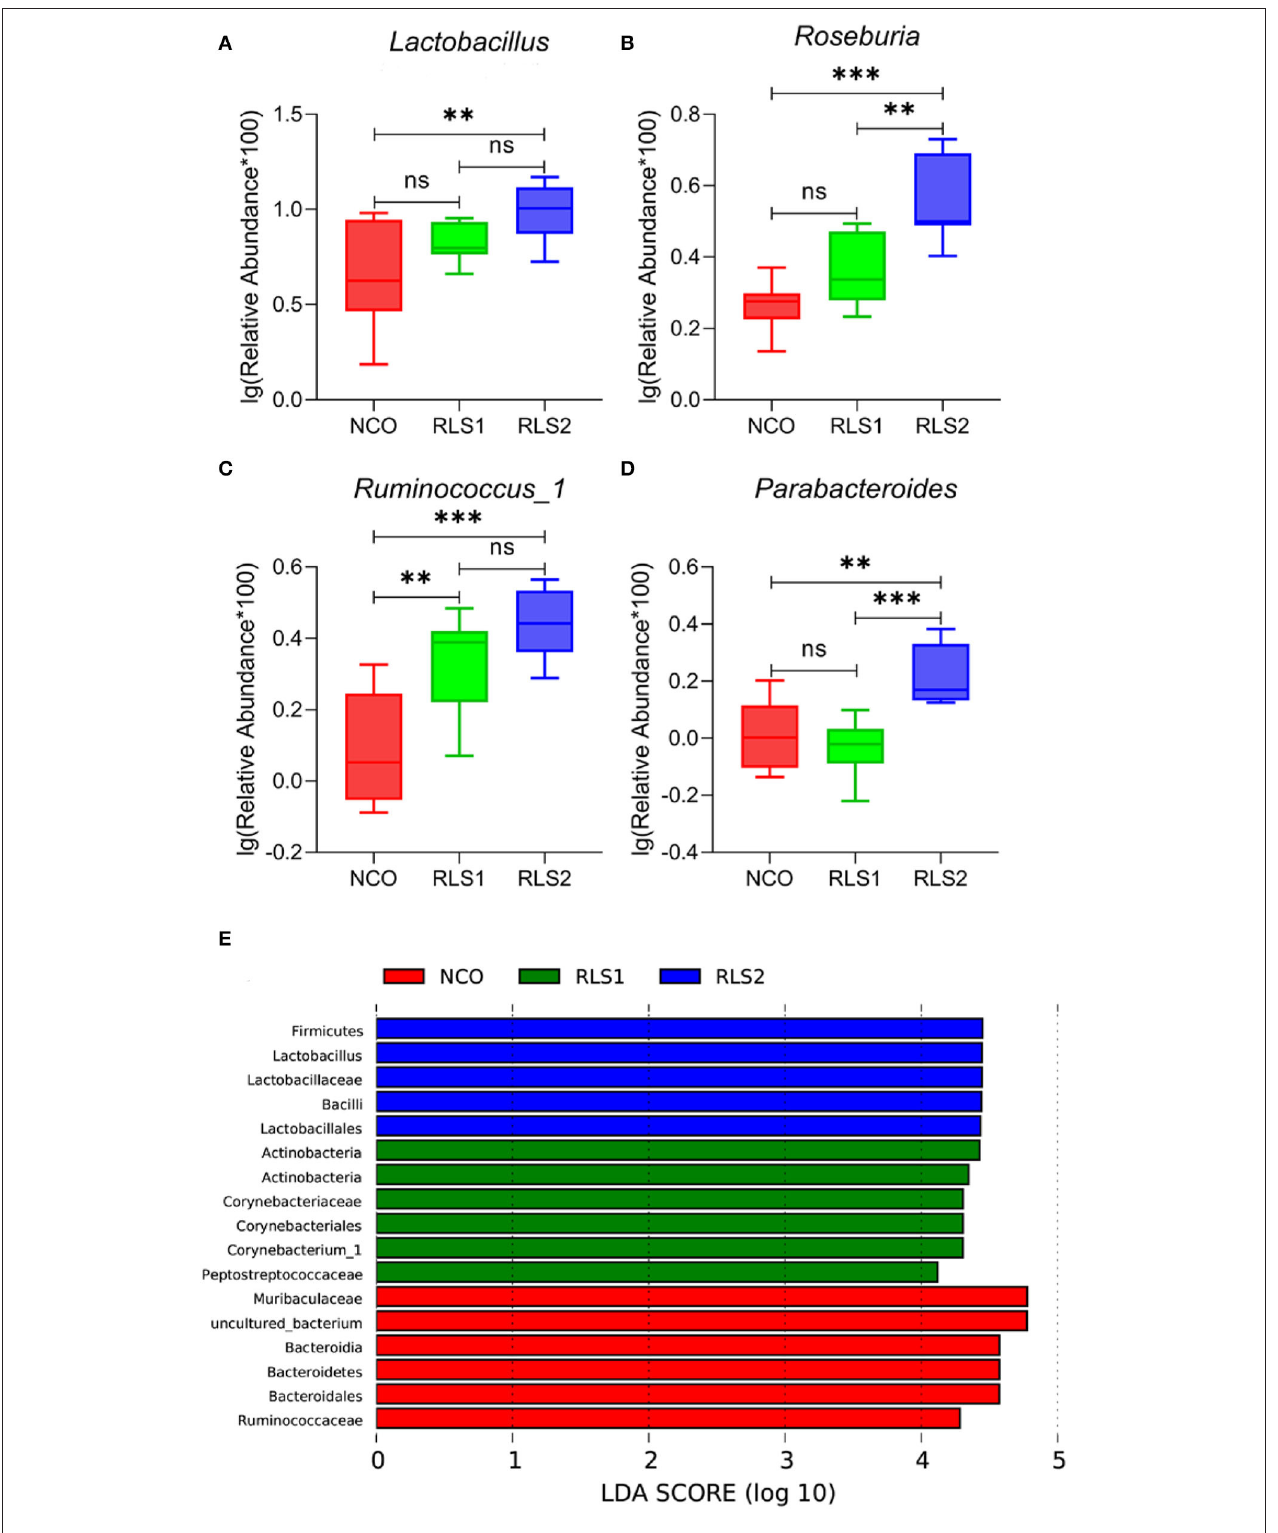
FIGURE 6 | Significant genera and LEfSe analysis. NCO, rats were gavage-fed normal saline; RLS1, rats were gavage-fed 10mg RLS / 200g body weight; RLS2, rats were gavage-fed 20mg RLS / 200g body weight. (A–D) The significant genera in the three treatment groups. (E) Histogram of LDA scores for taxonomic biomarkers by LEfSe analysis. LDA scores (log 10) > 2 indicate enriched taxa in cases. Data are shown as mean ± SEM and are analyzed by one-way ANOVA LSD test ( n = 8 in each group). ** represents P < 0.01, *** represents P < 0.001, ns represents not-significant.